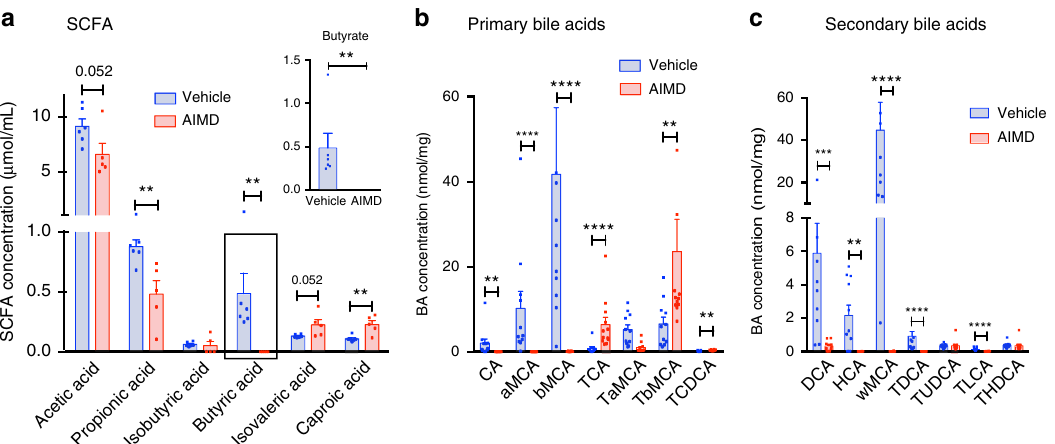
Fig. 3 AIMD affects SCFA and BA pro fi les in the cecum. a Absolute quanti fi cation of the level of different SCFA in the cecal content. Insert: close-up of butyrate levels. Absolute quanti fi cation of primary ( b ) and secondary BAs ( c ) in the feces. CA cholic acid, aMCA α -muricholic acid, bMCA β -muricholic acid, TCA taurocholic acid, TaMCA tauro- α -muricholic acid, TbMCA tauro- β -muricholic acid, TCDCA taurochenodeoxycholic acid, DCA deoxycholic acid, HCA hyocholic acid, wMCA ω -muricholic acid, TDCA taurodeoxycholic acid, TUDCA tauroursodeoxycholic acid, TLCA taurolithocholic acid, THDCA taurohyodeoxycholic acid. Fecal samples were collected 2 – 3 weeks after intervention. Mann – Whitney U test, ** p < 0.01, *** p < 0.001. All error bars are SEM